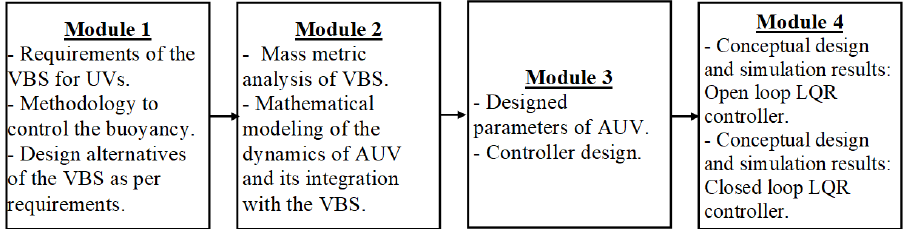
Figure 2. Basic modular structure of the Computer Simulation Model (CSM).